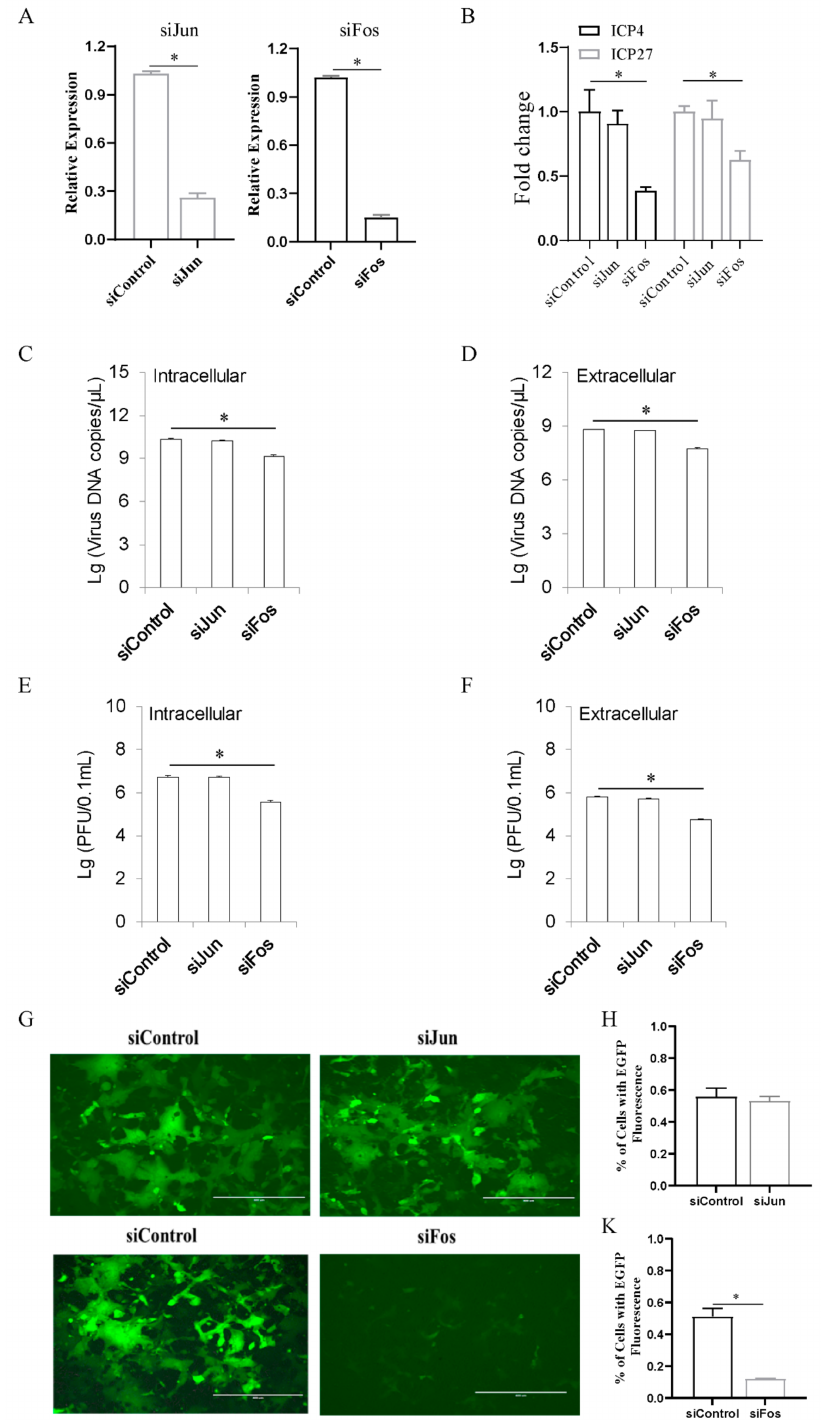
Figure 2. Fos is the key host determinant of ILTV replication in LMH cells. LMH cells were transiently transfected with Fos siRNA, Jun siRNA or negative control (NC) siRNA for 24 h. ( A ) The knockdown efficiencies of Fos siRNA and Jun siRNA were analyzed by qRT-PCR. ( B ) The transcription levels of ICP4 and ICP27 were quantitated 12 h after ILTV infection using qRT-PCR. ( C , D ) At 48 hpi, both the intracellular ( C ) and extracellular ( D ) viral genome copy numbers were determined by ILTV-specific qPCR. ( E , F ) The number of intracellular ( E ) and extracellular ( F ) infectious virions was quantified